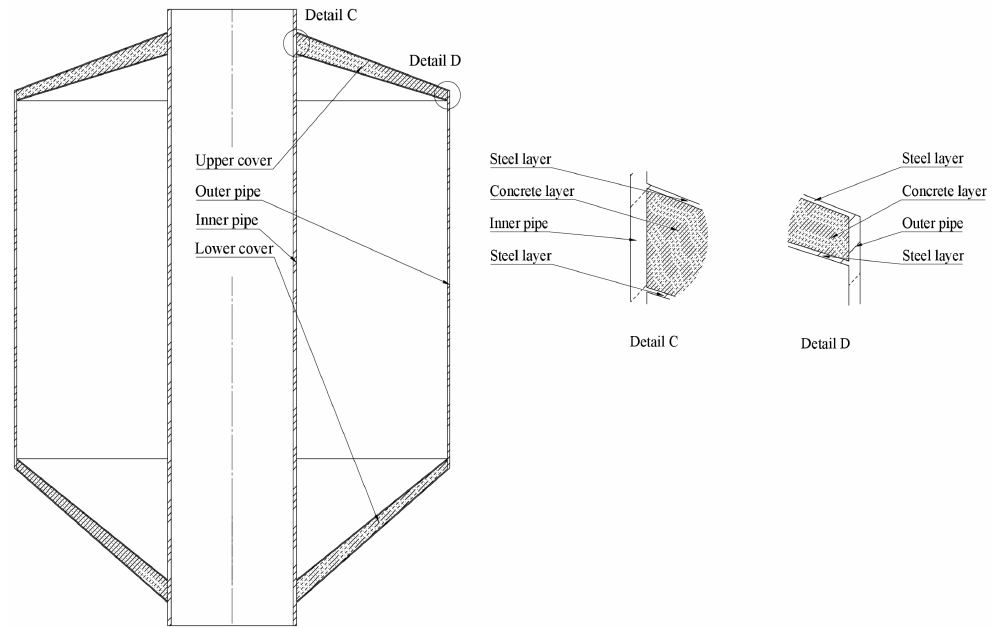
Figure 4. Technical drawing of the Universal Buoyancy Body in sectional view, the whole body on the left and details of the covers on the right, adapted from [3].